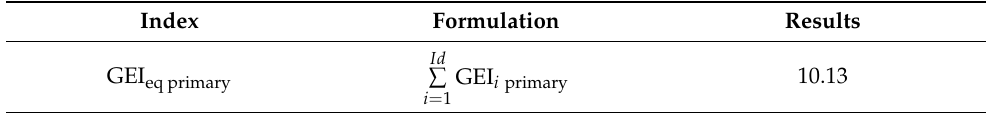
Table 7. GEI eq primary calculation for the modified second plant